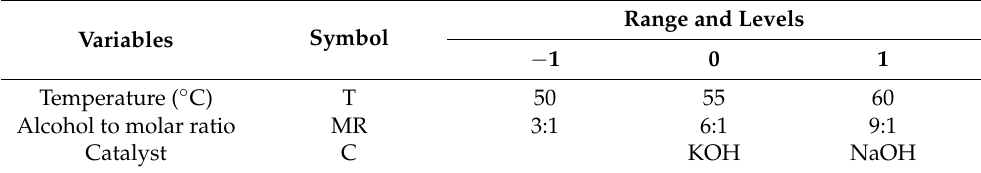
Table 1. Range and levels of parameters.